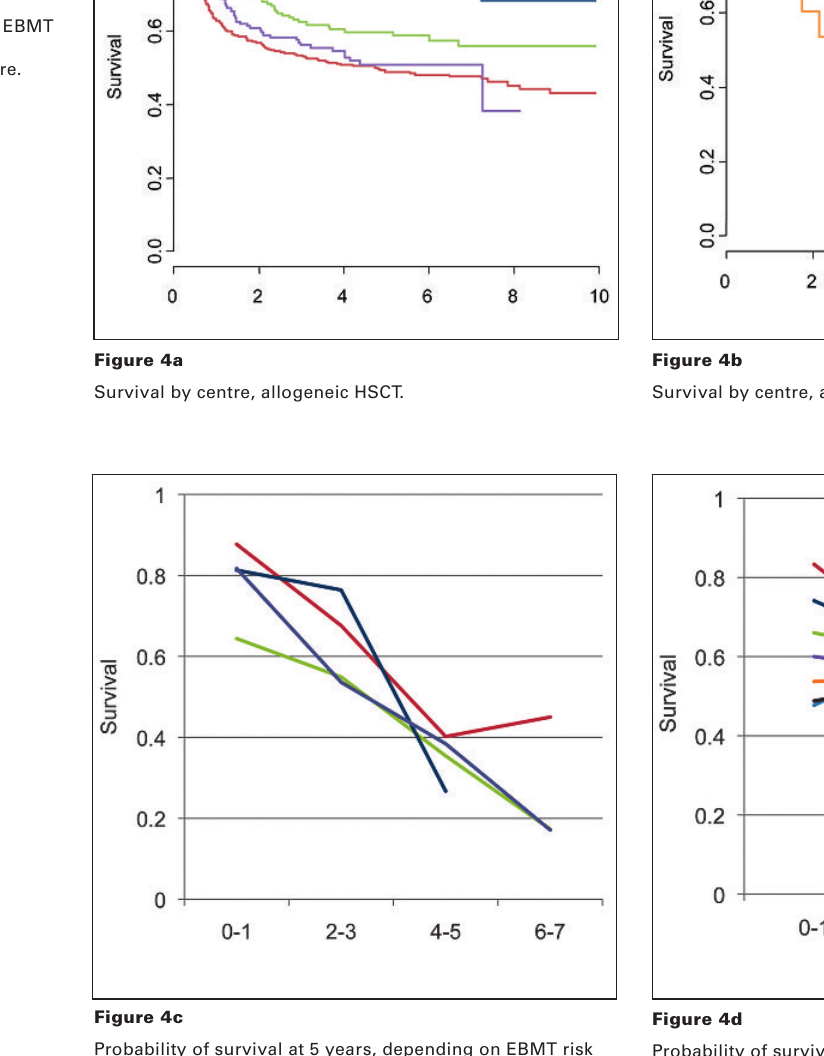
Probability of survival at 5 years, depending on EBMT risk score and centre, autologous